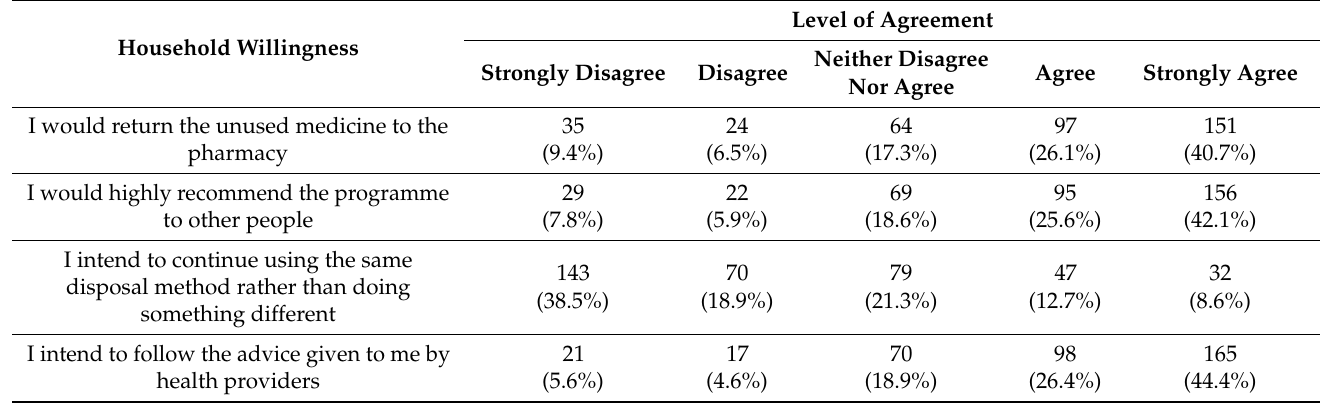
Table 5. Results on household willingness to return unwanted or unused medicines back to local